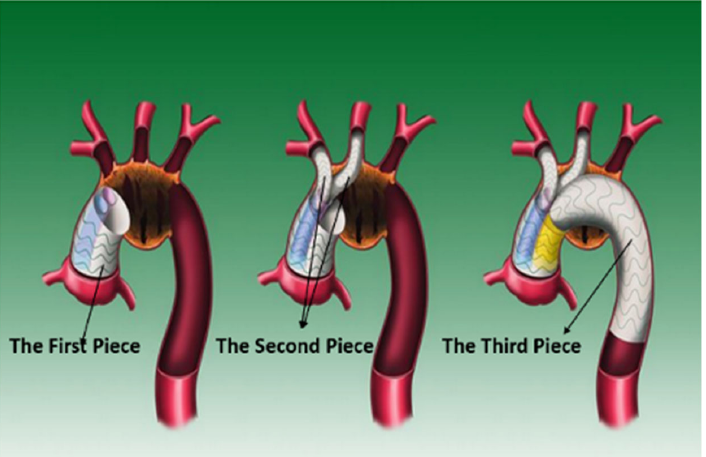
Figure 1. Diagram of the